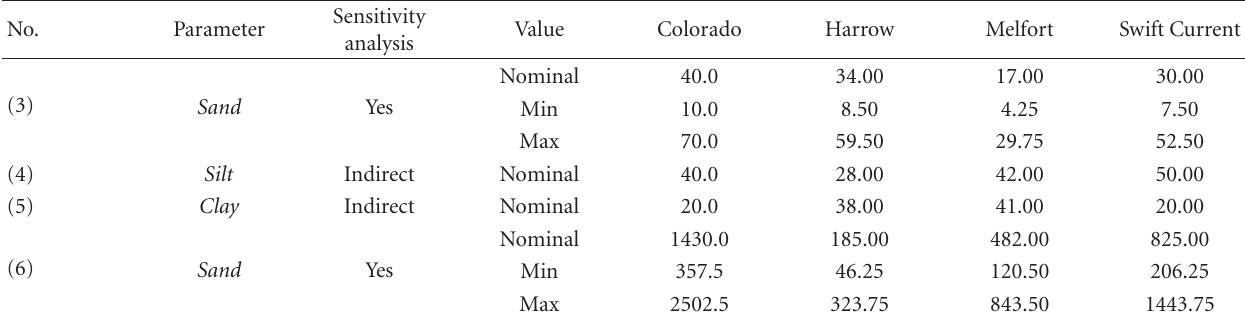
Table 2: Nominal value and range for parameters given site-specific